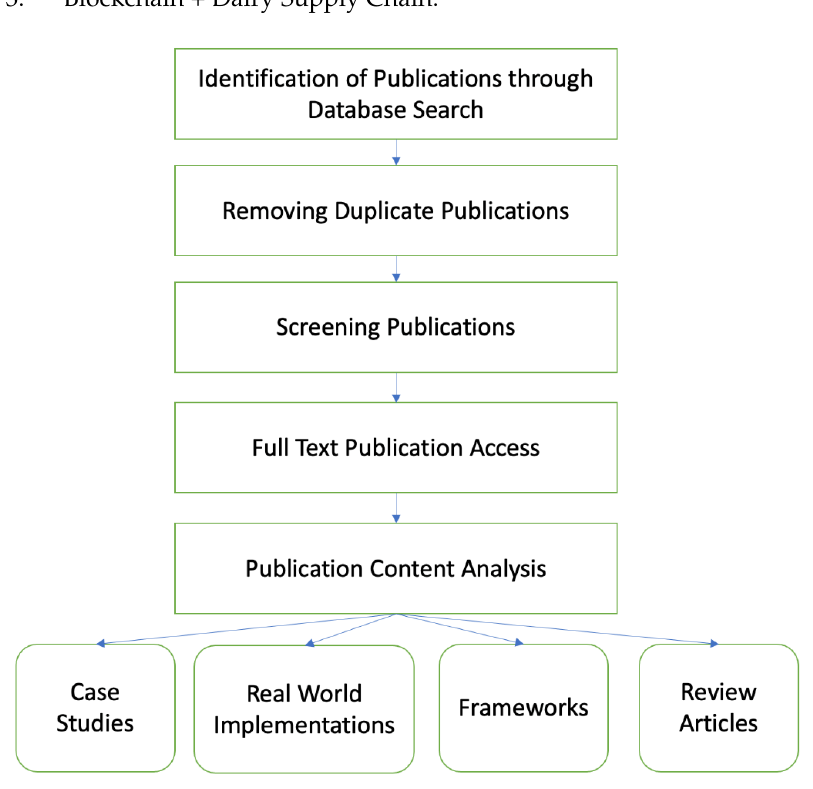
Figure 2. Research